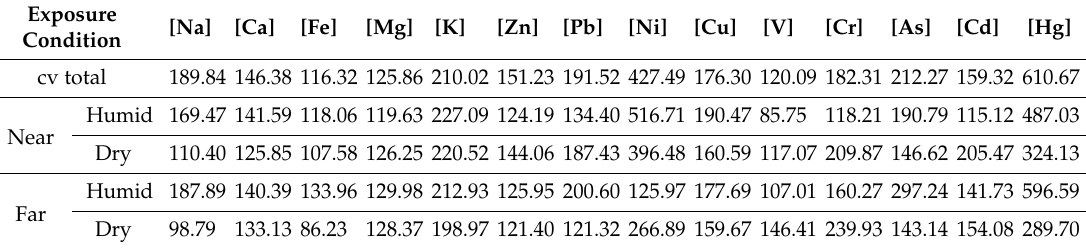
Table 5. Coefficients of variation calculated on the totality of accumulation data (cv total) and on data measured in same condition of exposure (humid, dry, near, far).